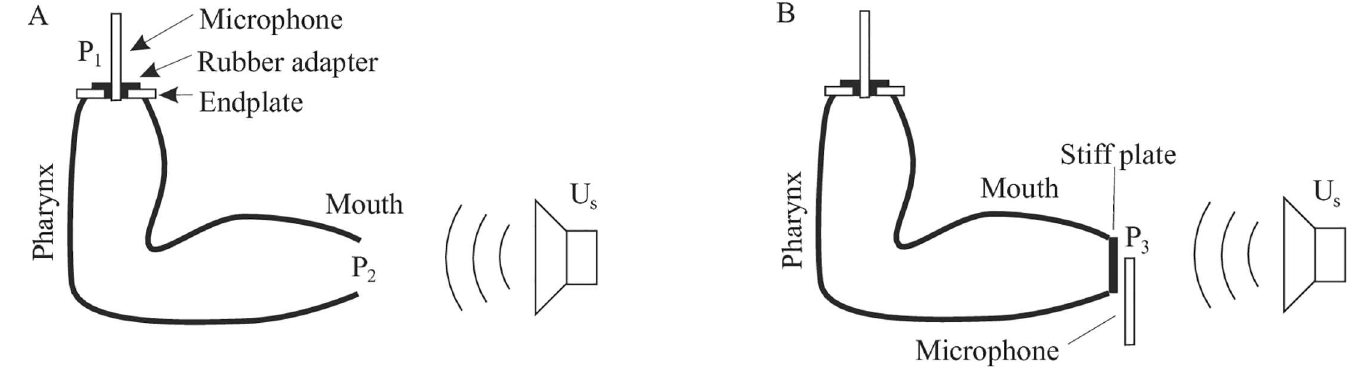
Fig 1. Experimental setup for measuring the vocal tract transfer function. (A) The mouth of the vocal tract model is open and the pressure P 1 is measured at the glottis. (B) The mouth of the model is closed and the pressure P 3 is measured right in front of the closed mouth.